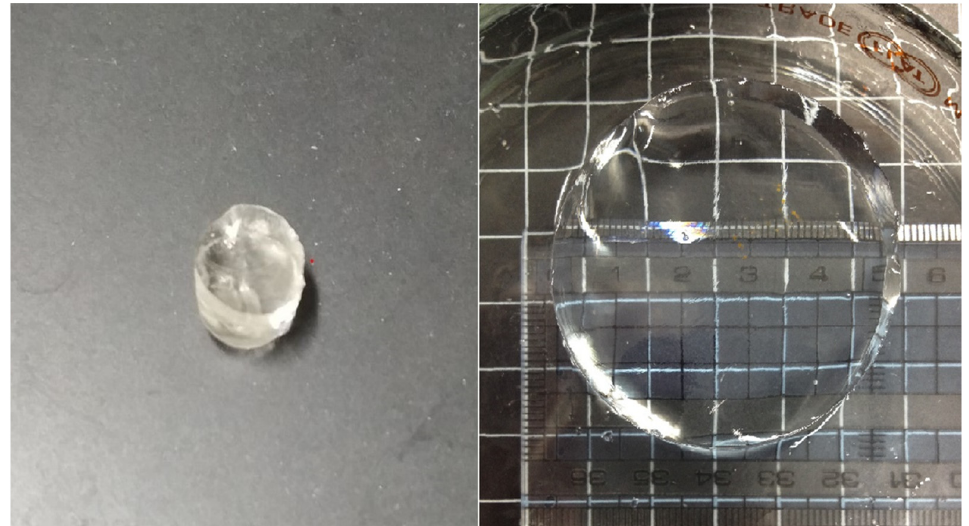
Figure 3. DADMAC-Aac-APTAC hydrogel before and after swelling.